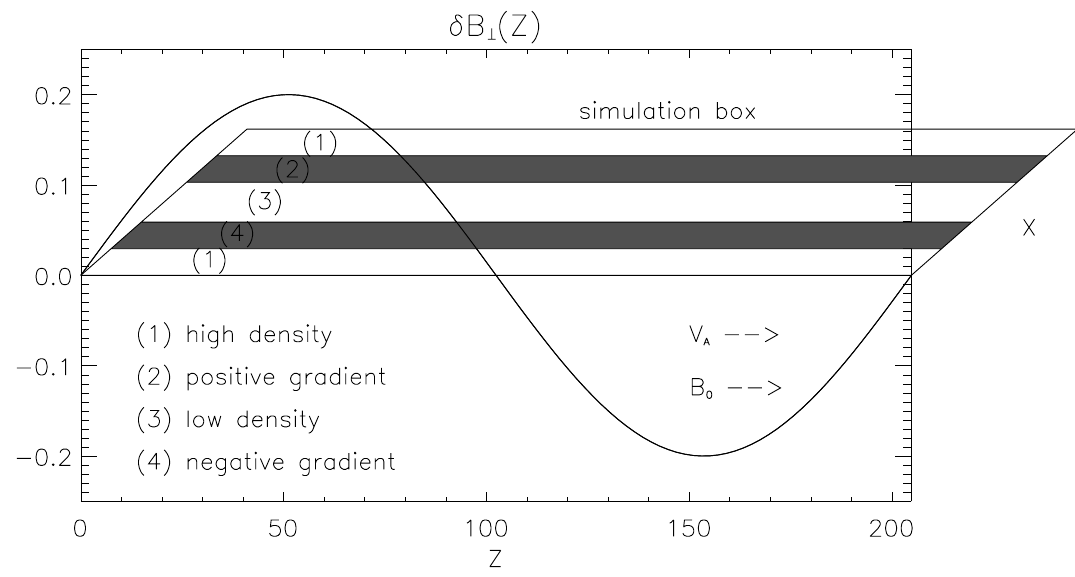
Fig. 1. Configuration of the simulation. The Alfv´en wave propagates in the Z direction and the density gradients are in the X